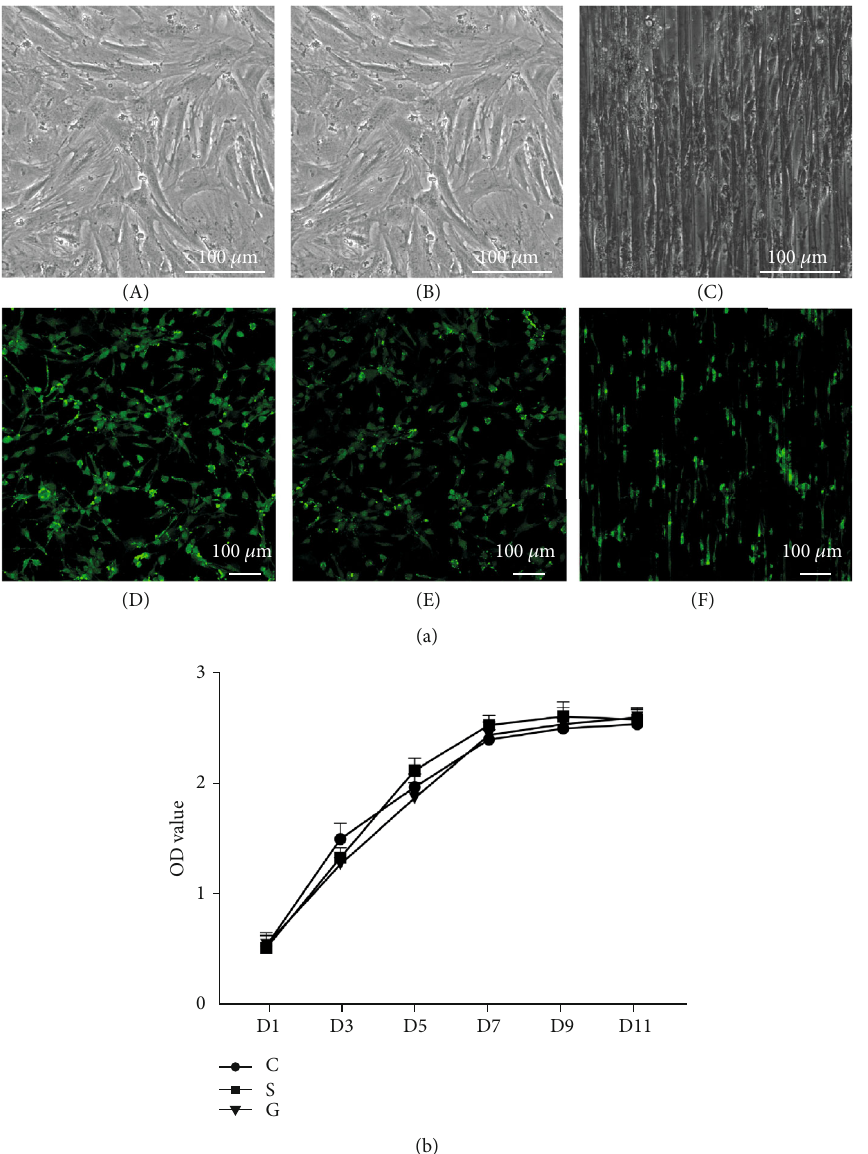
Figure 4: Live/dead cell staining and CCK-8 assay. (a) (A – C) Optical photomicrographs after TSPCs reached 90-100% con fl uence; (D – F) live/dead staining of TSPCs on the tissue culture plate (D), SF fi lm with a smooth surface (E), and SF fi lm with microstructure (F). (b) The CCK-8 curve of the di ff erent groups; group C: TSPCs on the cell culture plate; group S: TSPCs on the smooth SF fi lm; group G: TSPCs on the SF fi lm with a